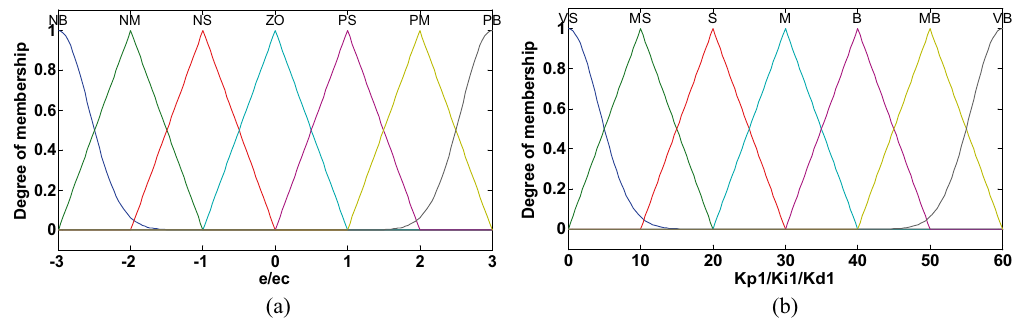
Figure 4. Membership function of FLS1: ( a ) input variables ( b ) output variables.